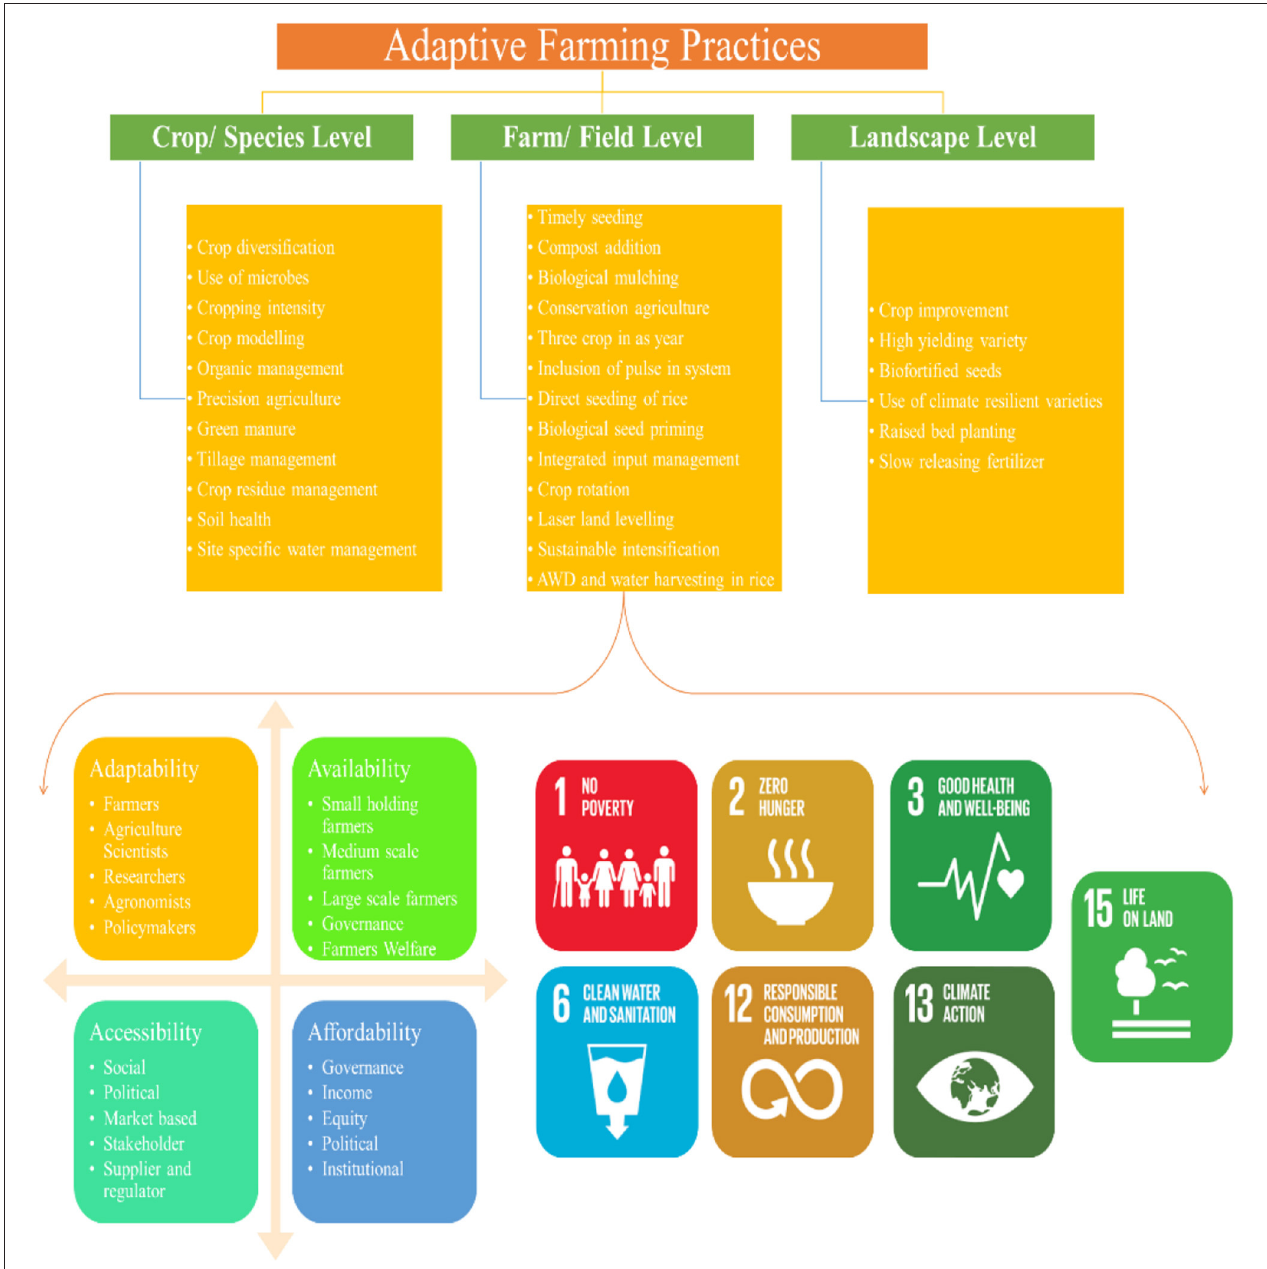
FIGURE 1 | Adaptive farming practices that can be implemented at different levels. Factors responsible for attaining global food security (i) adaptability, (ii) availability, (iii) accessibility, and (iv) affordability. Targeted UN sustainable development goals (SDGs) goals numbers 1 (No Poverty), 2 (Zero Hunger), 3 (Good health and Wellbeing), 6 (Clean Water and Sanitation), 12 (Responsible Consumption and Production), 13 (Climate Action), and 15 (Life on Land) (Adopted and modified from Dubey et al.,